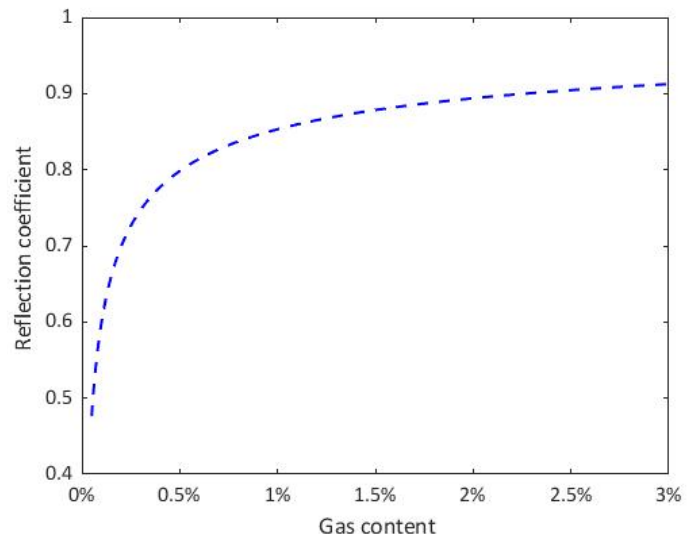
Figure 1. Reflection coefficient vs. gas content at the vertical incidence of acoustic waves at the infinity interface of liquid-bubbly liquid.